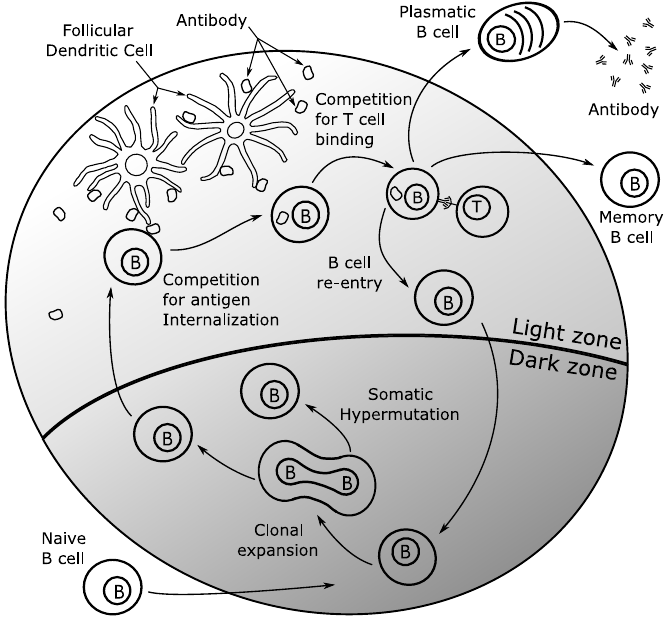
Figure 1. Germinal Center reaction.